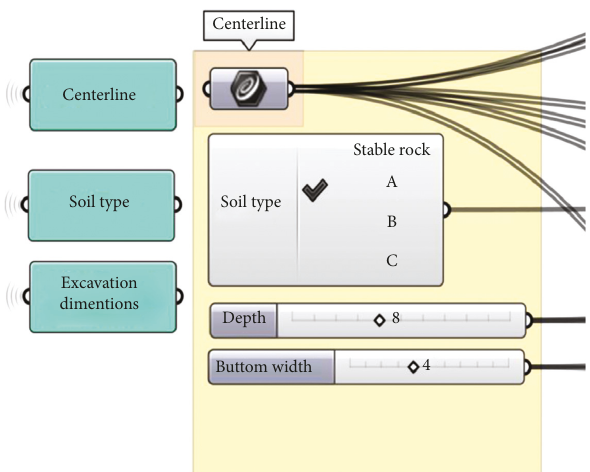
Figure 6: Soil classification and dimension constraint algorithm.